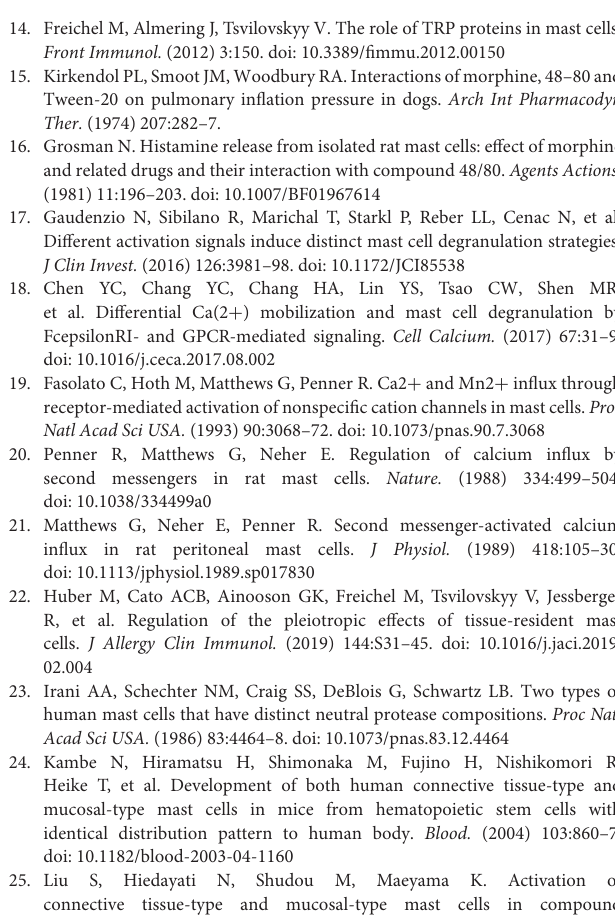
Figure S1 | Mrgprb2 agonists without Ca 2 + mobilizing effects in BMMC or PMC murine mast cells. Measurements of [Ca 2 + ] i changes performed with Fura-2 and presented as F340/F380 fluorescence ratio in BMMC (A–C,E) and PMC (D,F) isolated from WT mice. Representative traces ( n = 20 each panel) of [Ca 2 + ] i changes (error bars indicate S.E.M.) induced by application of 3 µ M of LL-37 (A,B) , 1 µ M L-Carnosine (C,E) , and 10 µ M of L-Carnosine (D,F) . The measurements were performed in 3–5 independent cell preparations. At the end of recordings, control reactions were elicited by application of 10 µ M adenosine “Ad” (A–C,E) or by application of 50 µ M Compound 48/80 “Cmp” (D,F)